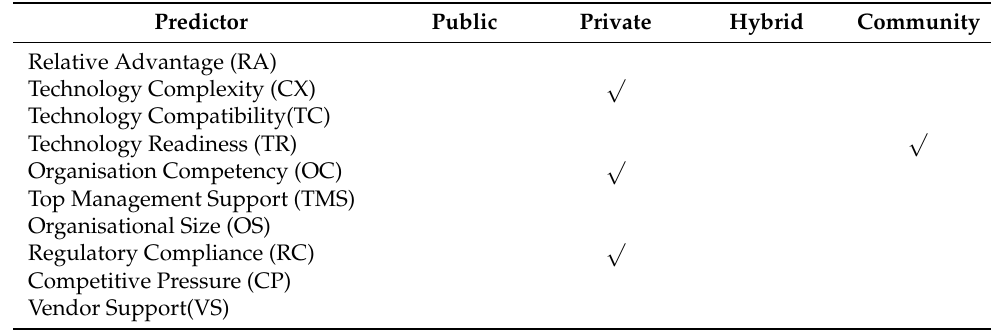
Table 11. Hypothesis testing per service deployment.